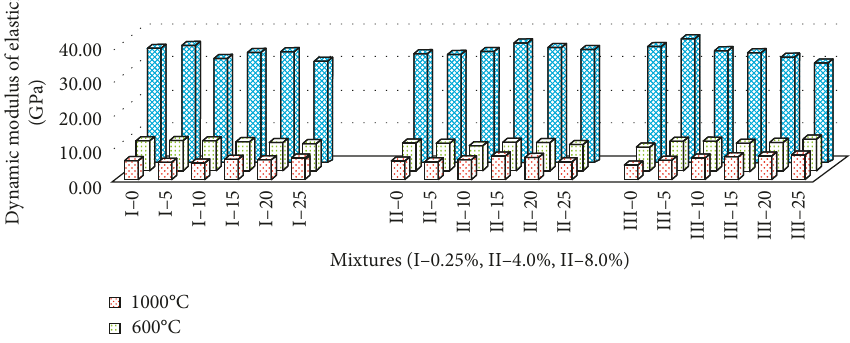
Figure 7: Fracture energy of studied mixtures.